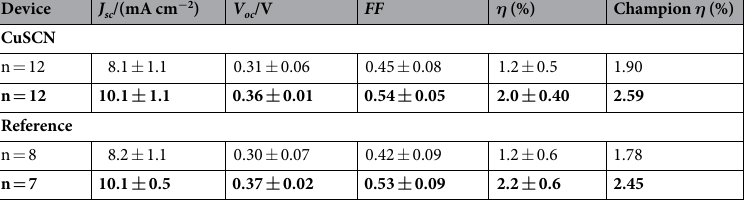
Table 1. Average current-voltage ( JV ) parameters for PPV devices ( ± one standard deviation) with the